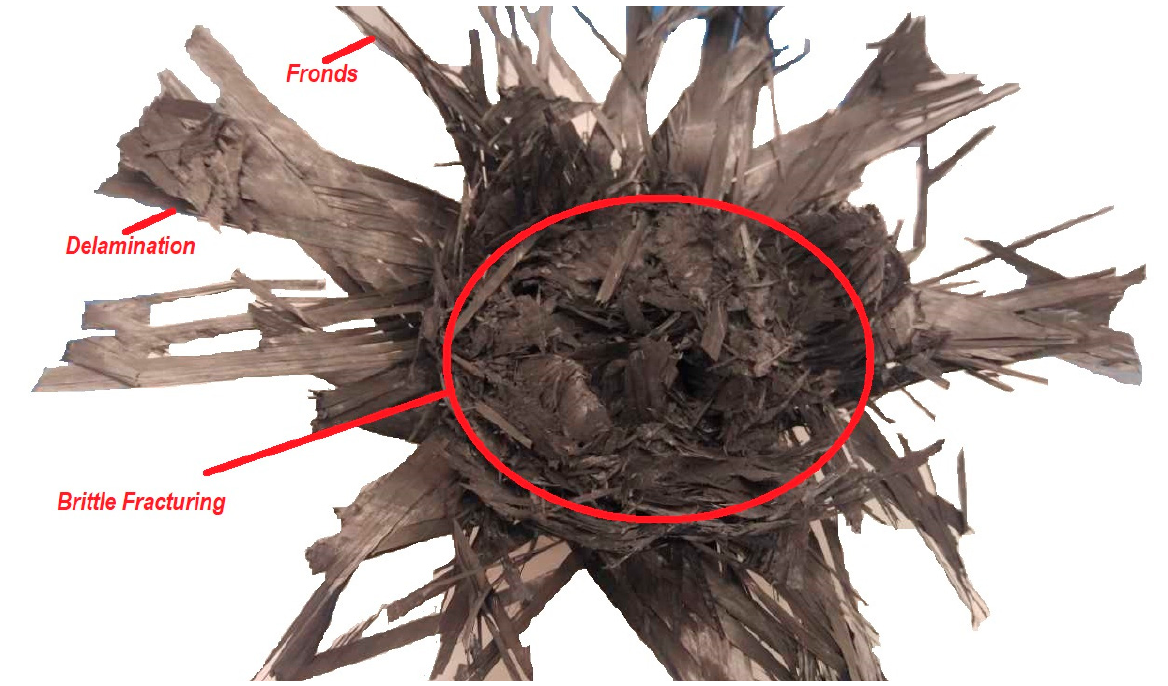
Figure 5. Representative collapse modes of 50 mm dia composite circular CFRP tubes, exhibiting many of the failure modes depicted by Farley [7] for regular CFRP tubes, as shown in Figure 2.